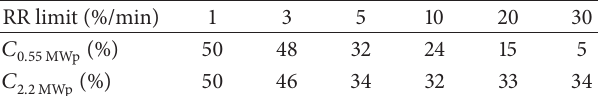
Table 1: The relative difference of the UNav ESS energy capacity requirements with respect to the TUT requirements for different ramp rate limits and the two sizes of PV